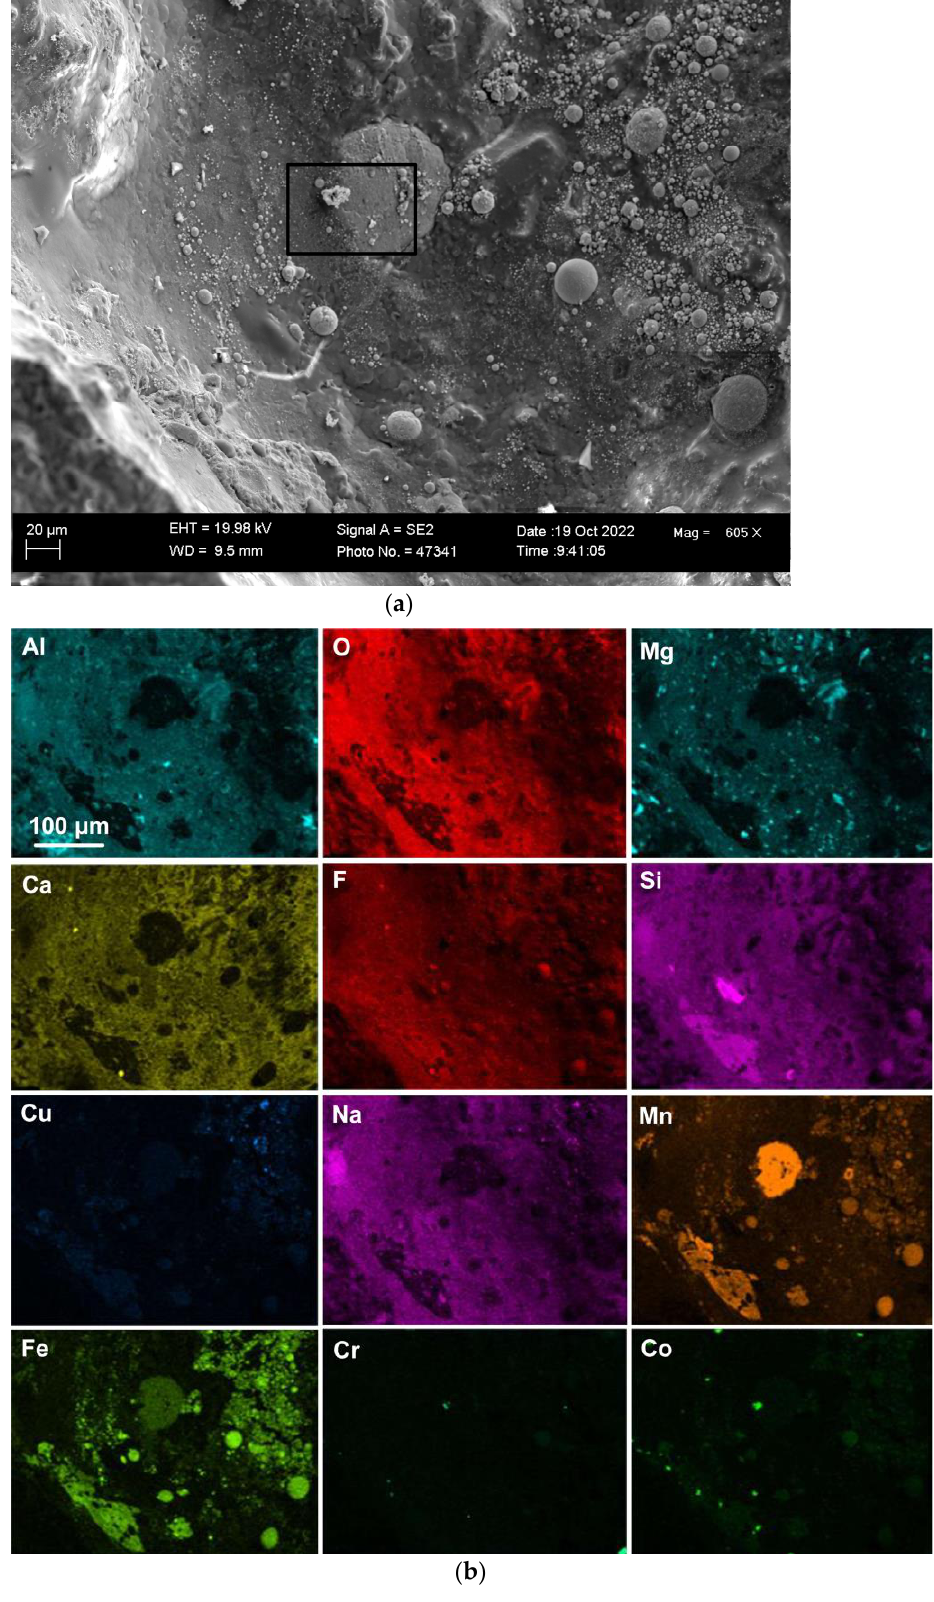
Figure 4. ( a ) BSE image at 605× magnification showing a slag dome with 3D structures in the MP11 post-weld slag; ( b ) EDX maps of the FOV (field of view) in Figure 4a.